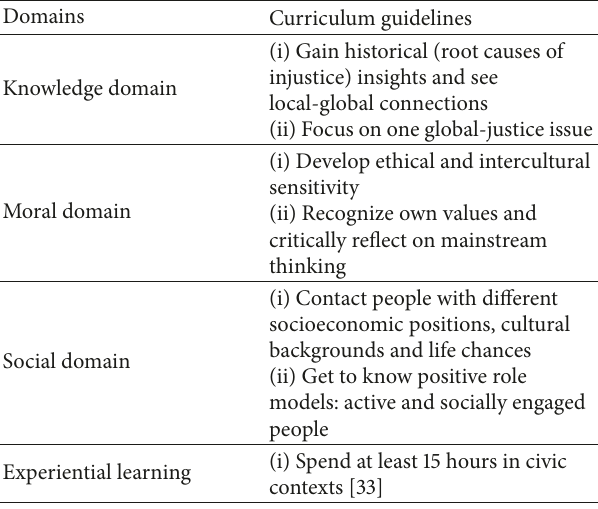
Table 1: Curriculum guidelines Global Justice Citizenship Educa-